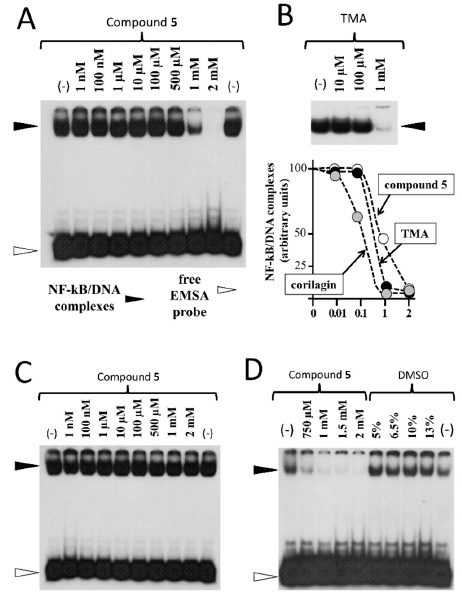
Figure 6. Effects of compound 5 on NF- κ B/DNA interactions. ( A ) Compound 5 was pre-incubated